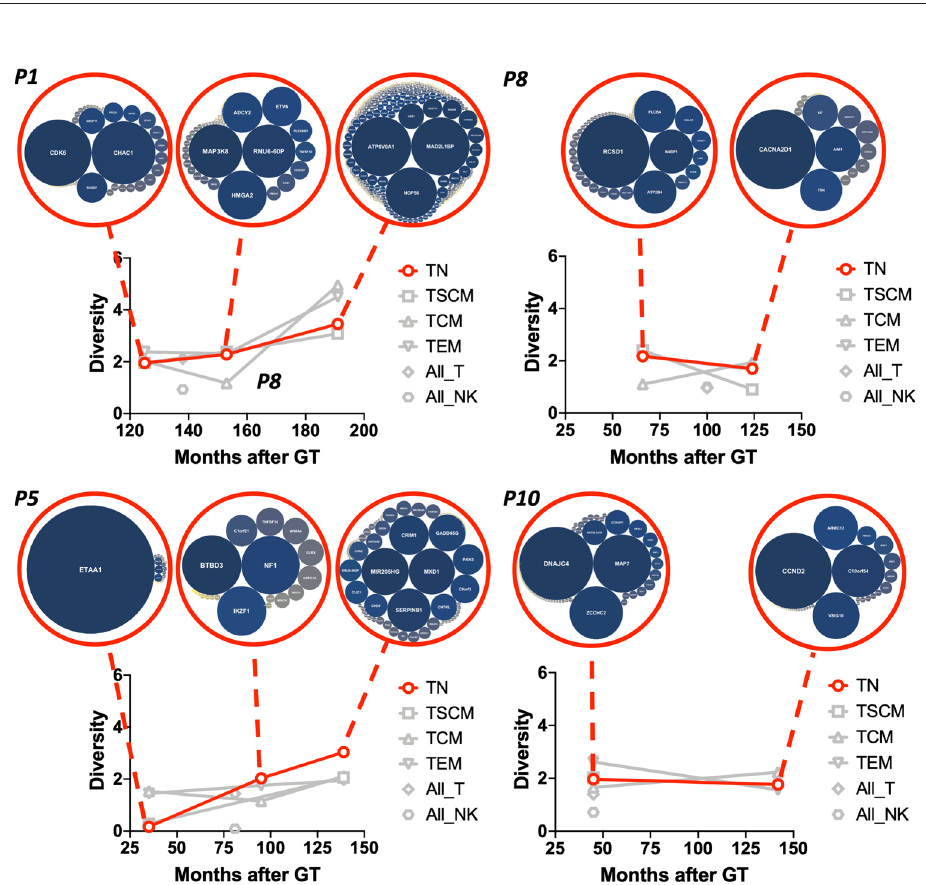
Fig. 3 Assessment of thymic activity in GT patients. A T-cell receptor excision circles (TREC) content measured in CD4 + and CD8 + cells in fi ve patients overtime. B Ring plots displaying the relative fractions of TCR rearrangements detected within each T-cell subtype sorted from a healthy donor control (HD) and two patients (P8 and P10) at two timepoints each (months = M) after GT. Numbers inside each ring correspond to the numbers of individual TCR rearrangements retrieved from each sample. C Diversity of TCR rearrangements shown as a 2-dimension t-SNE plot. Coordinates are derived from computing the differences (distance) among clones in sequence composition of a 50 bp window centred on the Complementarity-determining region 3 (CDR3). The size of each dot is proportional to the abundance of the corresponding TCR rearrangement. In these graphical representations the higher it is the spread of dots across the area of the plot the higher it is the diversity of rearrangements observed within the TCR locus. D TCR diversity measured by Shannon Diversity index in each sample and T-cell subtypes of HD, P8 and P10. E Diversity of TCR repertoire in naïve T cells (TN) of HD (grey bar) and Patients (red bars) at different timepoints). F Networks displaying TCR sharing between the four T-cell subtypes from HD or P8 and P10 at each follow up. Nodes represent T-cell subtypes while edges (arrows) represent degree of TCR sharing. Size of each node is proportional to the number of TCR rearrangements detected in each T-cell subtype (Naïve T cells [TN] in light green, other subtypes in light blue). The thickness of the arrows is proportional to the Pearson correlation coef fi cient calculated on the basis of TCR sharing between each pair of T-cell subtype. G Violin plots showing percent of TCR recaptured within each T-cell subtype isolated from two patients at two independent timepoints.